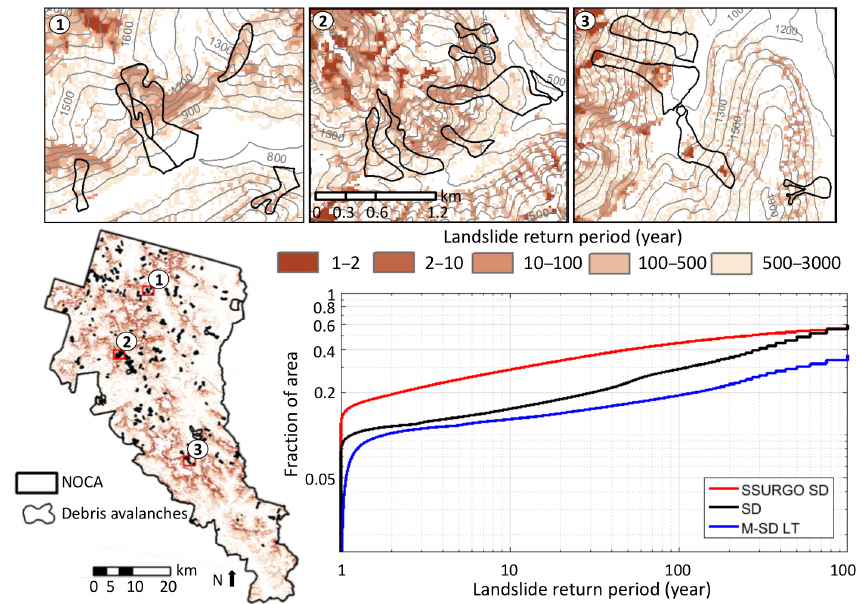
Figure 11. Modeled landslide return period simulations with M-SD LT for NOCA overlain with mapped debris avalanches, including zoomed in areas at the top for greater detail. Cumulative distribution of return periods for SSURGO-SD, M-SD, and M-SD LT scenarios, plotted on a log–log scale using the Weibull plotting